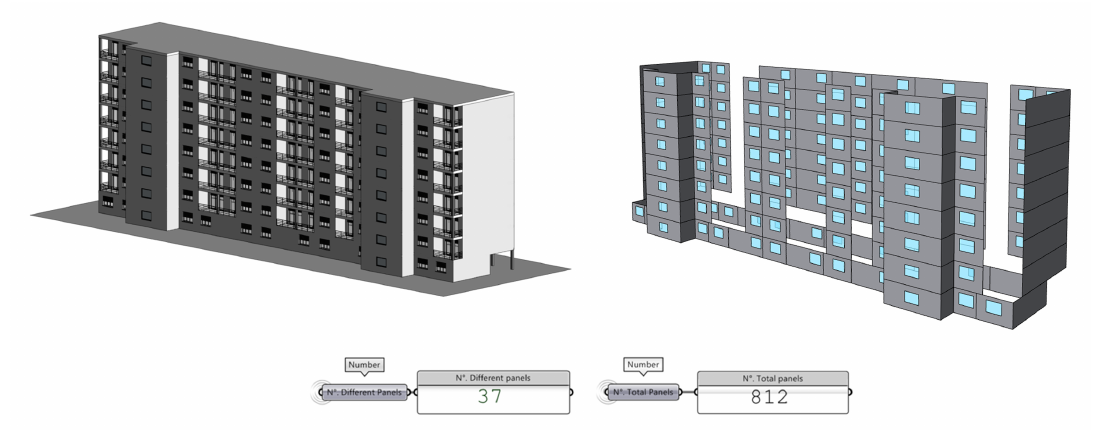
Figure 2. As-is BIM model and First panelisation phase with meta-technological panels. The total number of panels and the number of different panels considered is automatically displayed.